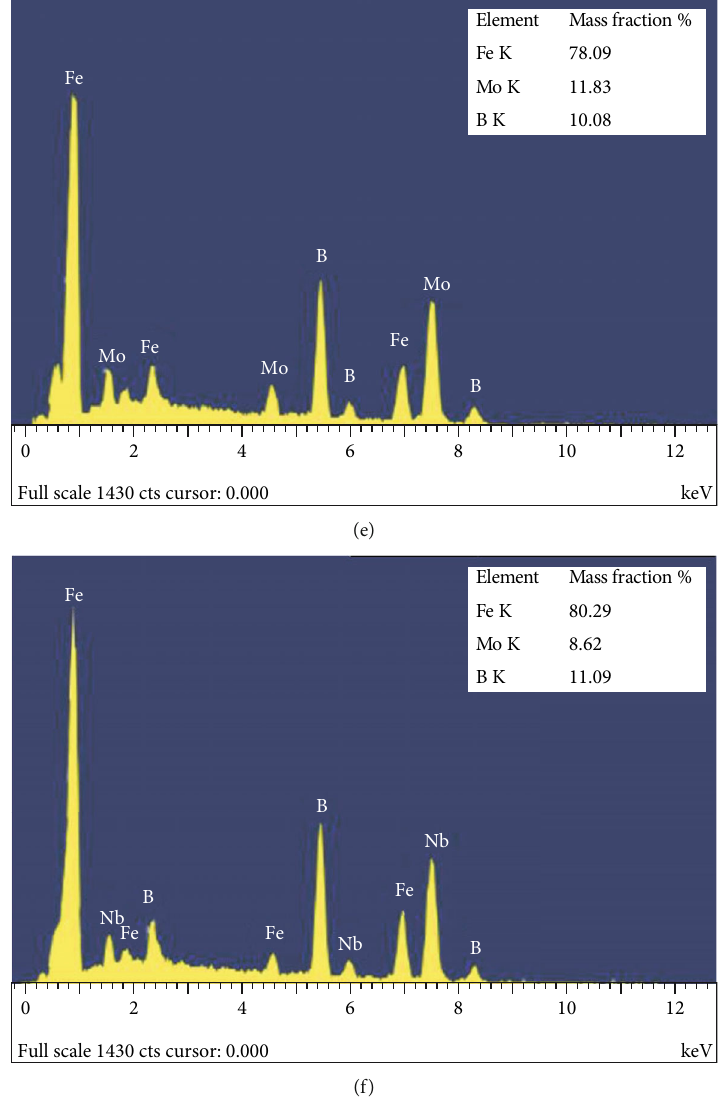
Figure 5: EDS spectra of GH4720Li alloy under di ff erent deformation conditions: (a) 10 s -1 , 20 ° C; (b) 10s -1 , 800 ° C; (c) 1000 s -1 , 20 ° C; (d) 1000s -1 , 800 ° C; (e) 5000 s -1 , 20 ° C; (f) 5000 s -1 , 800 ° C.